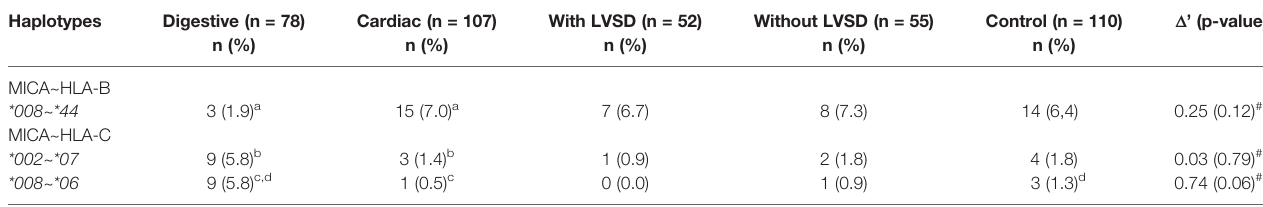
TABLE 3 | Haplotype frequencies of MICA, HLA-B and HLA-C in patients with the digestive or cardiac forms of chronic Chagas disease, in patients with LVSD and without LVSD and in control individuals. Haplotypes